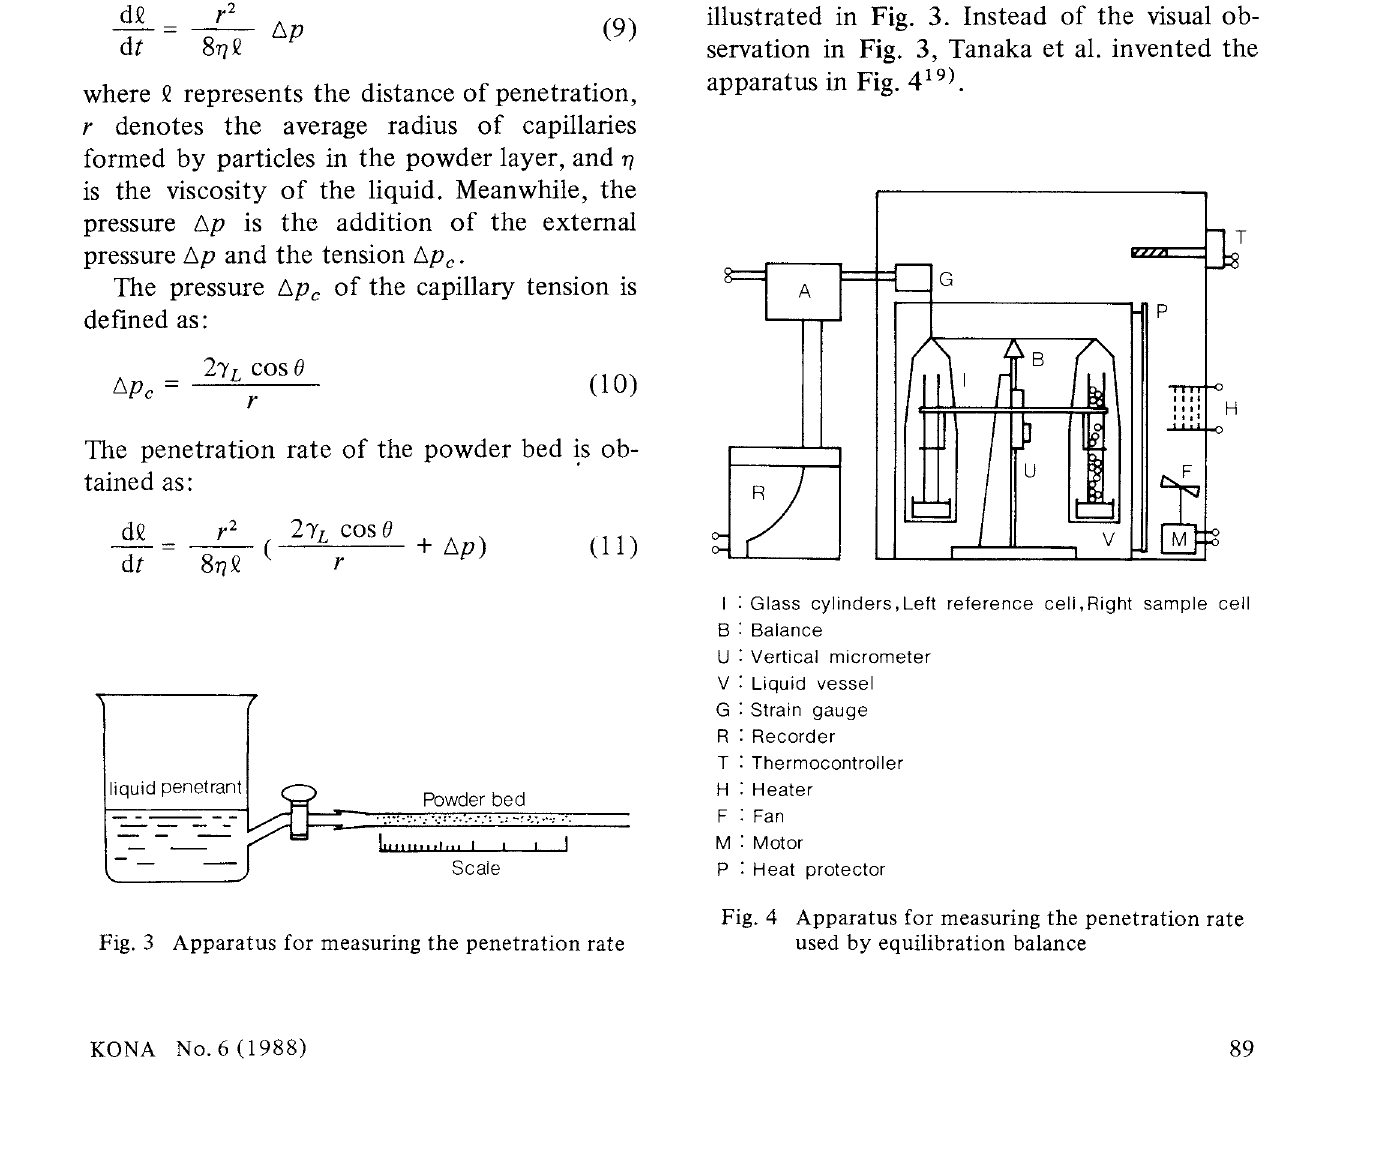
Fig. 3 Apparatus for measuring the penetration rate